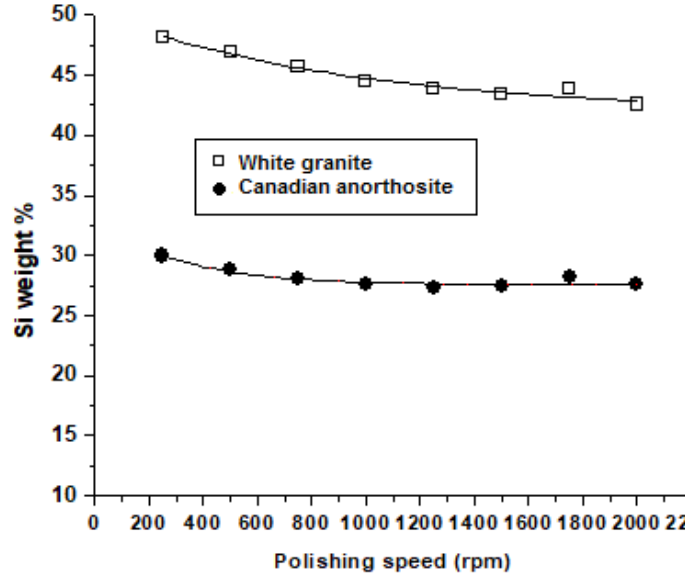
Figure 11. Variation of Si weight percent in emitted particles at different polishing speeds for the tested stones (feed rate—508 mm/min; grid size—60; pressure—0.2 bar).